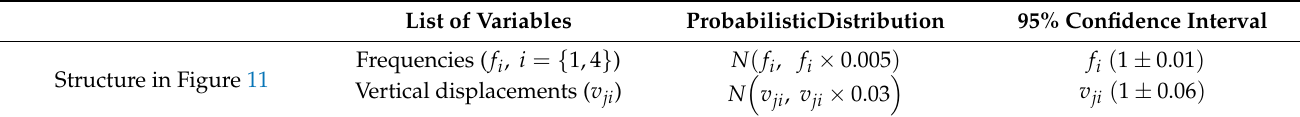
Figure 12. ( a ) The first experimental bending mode and its frequency; ( b ) the second experimental bending mode and its frequency; ( c ) the third experimental bending mode and its frequency; ( d ) the fourth experimental bending mode and its frequency [11]. Table 7. Measurement input variables (averaged values for the 31 measured